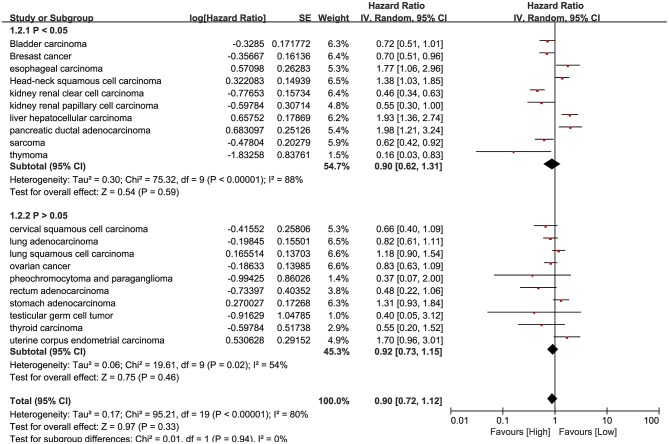
Forest plot shows the result of pan-cancer survival analysis. The upper subgroups are composed of studies whose P-value is <0.05, the below subgroups are more than 0.05.